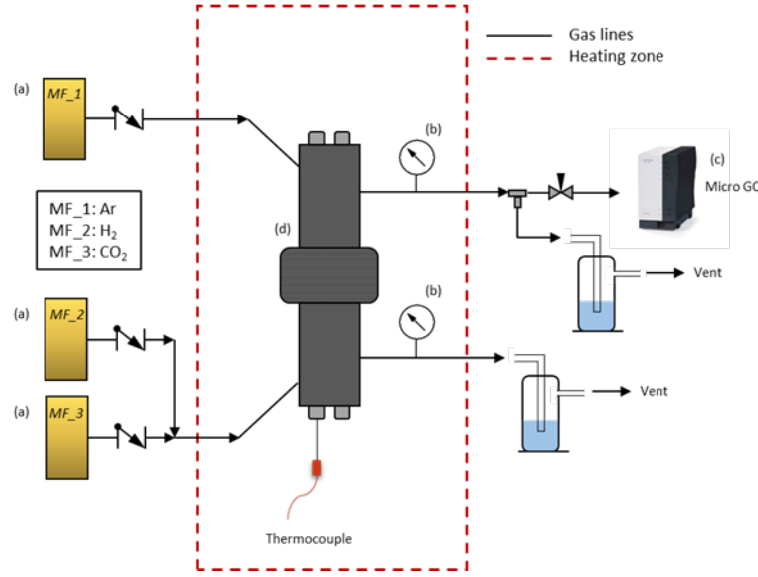
Figure 2. High-temperature set-up for polymeric membranes.